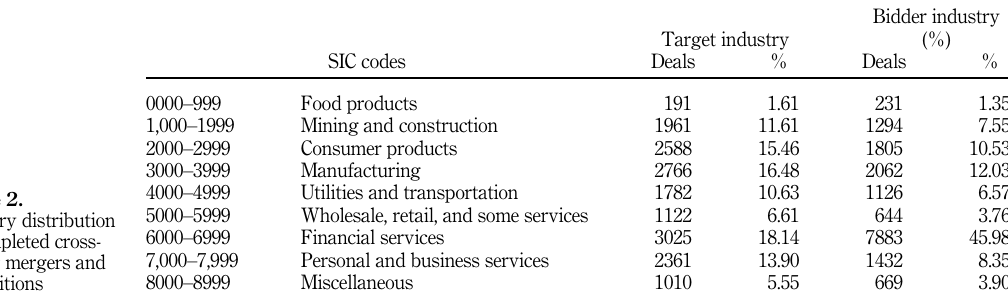
Table 2. Industry